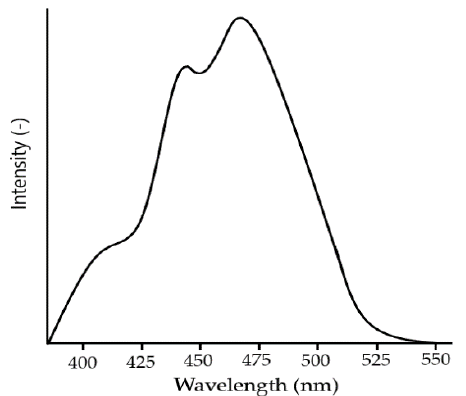
Figure 14. Absorption rate of visible light wavelength of BFO material.